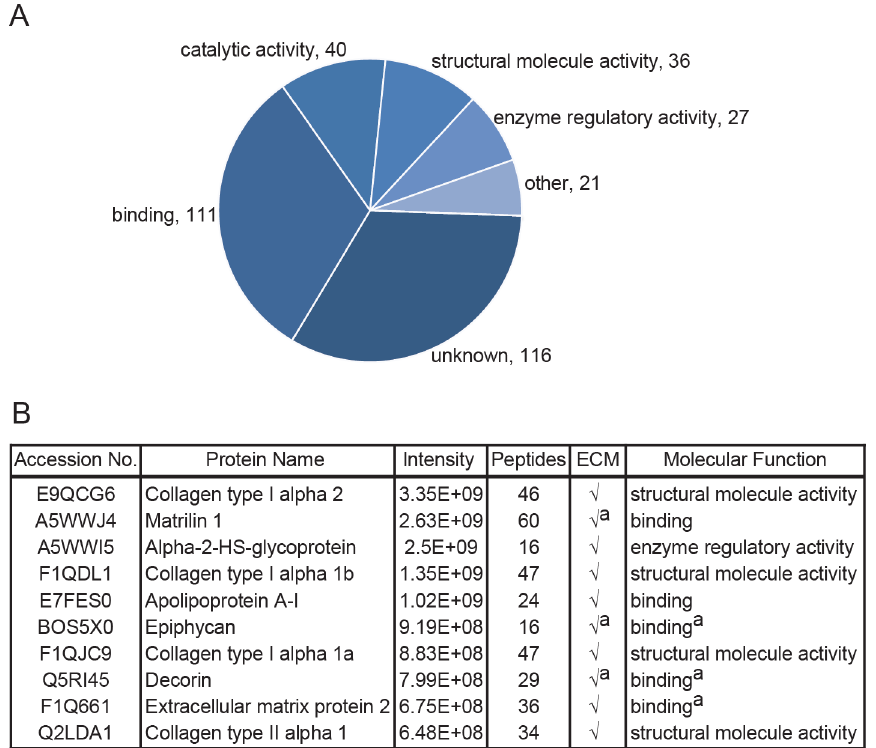
Figure 1. Composition of the zebrafish extracellular protein profile. (A) Distribution of molecular functions for the proteins identified as extracellular proteins. a Gene Ontology information based on the human ortholog of a protein in case this information was absent in the zebrafish database. The diagram contains 351 entries corresponding to 262 different proteins of which some fall into multiple categories (B) Ten most abundant extracellular proteins within the obtained protein profile based on their intensity.